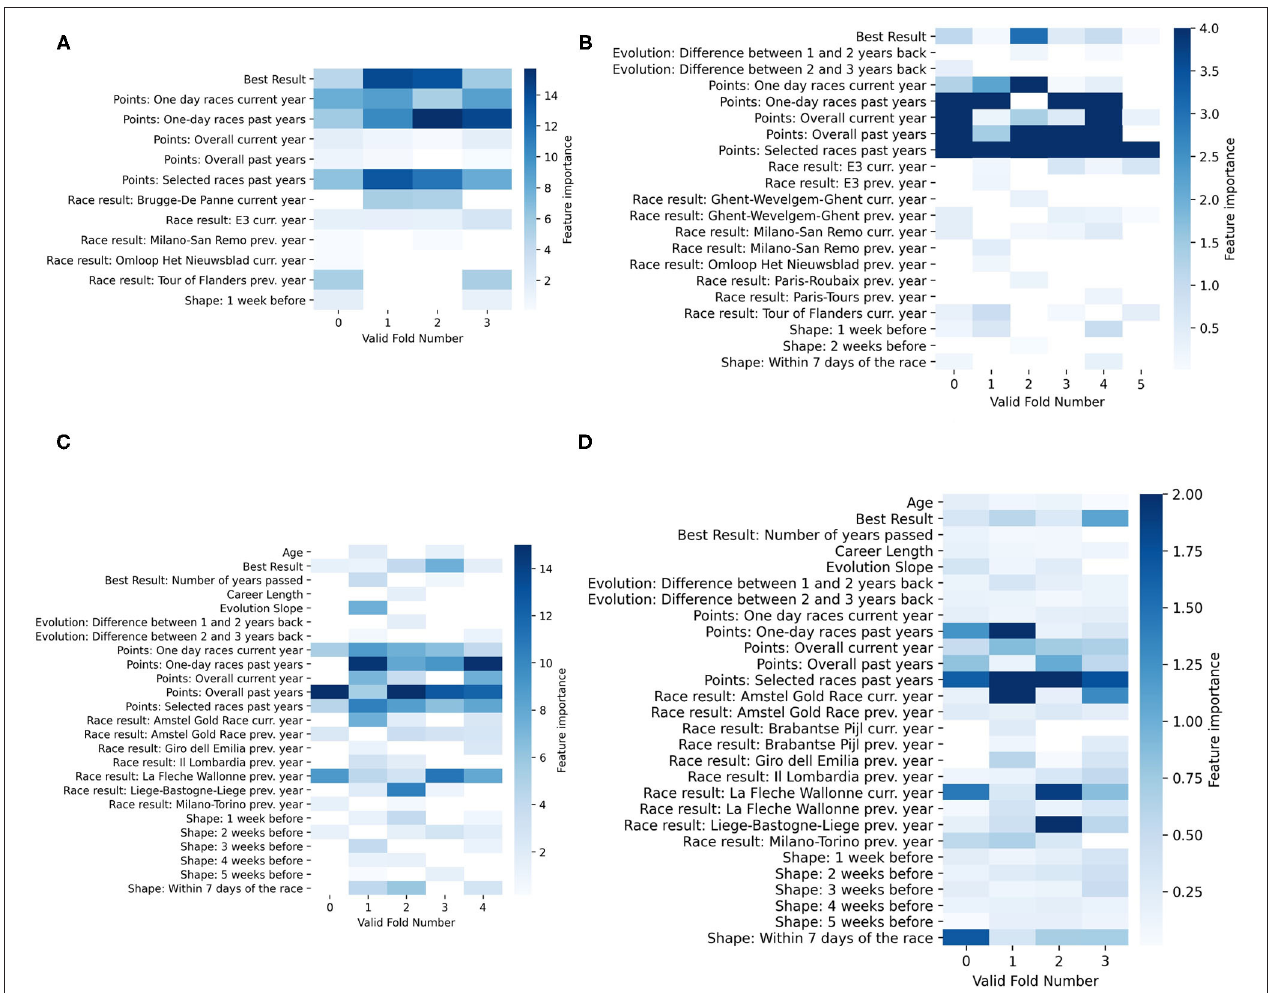
FIGURE 8 | Feature importance for each of the valid cross-validation fold of the model of Tour of Flanders (A) , Paris-Roubaix (B) , La Flèche Wallonne (C) , and Liège-Bastogne-Liège (D) . The feature importance is determined by the average gain of the splits of the trees that use that feature. The higher the value, the more important is the feature. In (B–D) , the values have been clipped for visualization